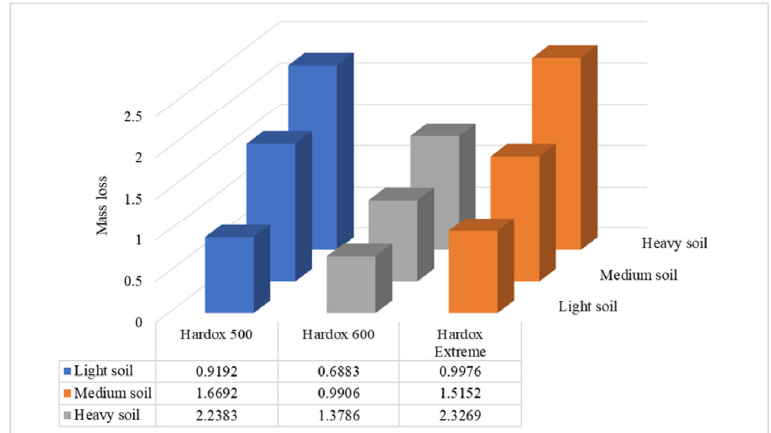
Figure 4. Total weight losses for test materials in particular soil